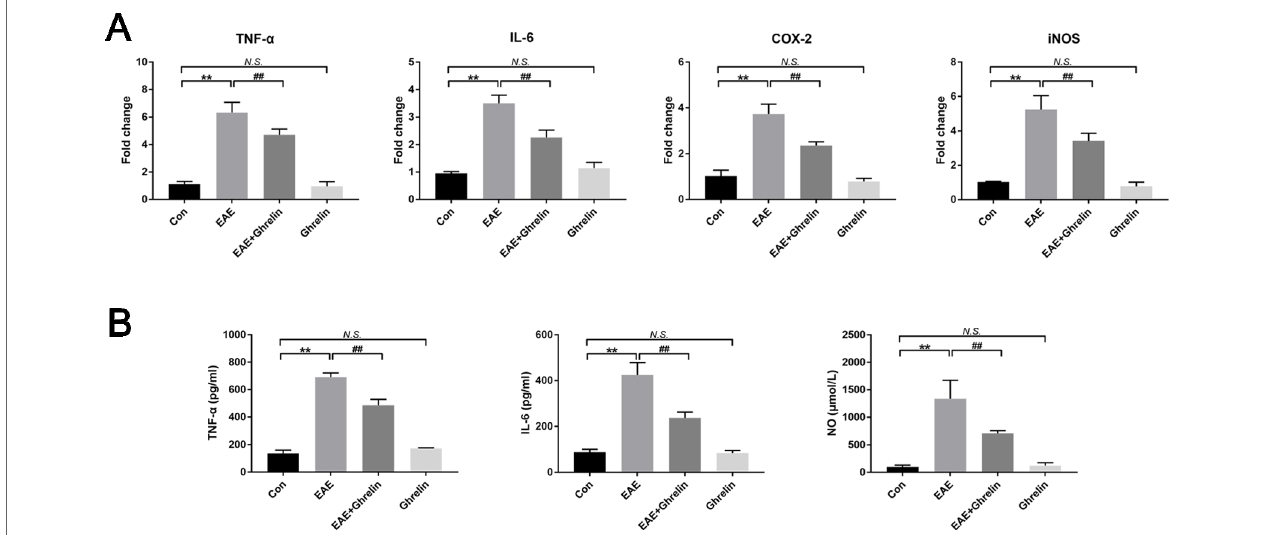
FIGURE 2 | Treatment of ghrelin decreased the production of inflammatory cytokines of EAE rats. (A) The mRNA expressions of inflammatory cytokines were measured by quantitative RT-PCR ( n = 5). (B) Inflammatory cytokine expressions in serum were measured by ELISA ( n = 10). Expression of NO in serum was measured by a NO assay kit ( n = 10). Data were shown as mean ± SD.** P 0.01 versus the control group, ## P 0.01 versus the EAE group. NS , not significant. Con, control.